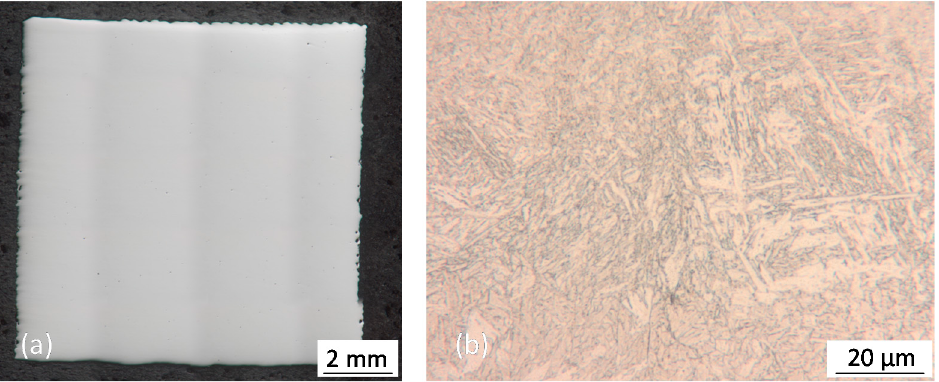
Figure 5. Cross-section of test sample used for density measurements ( a ) and a magnified etched cross-section of the same sample ( b ). Used additive manufacturing parameters: P L = 300 W; H = 40 µm, h = 120 µm, v s = 850 mm/s.